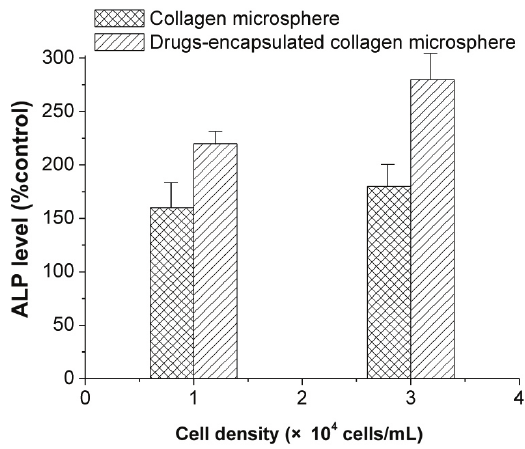
Figure 4. ALP expression level on pure collagen microspheres and drugs-encapsulated collagen microspheres after 7 days of culturing. Data are represented after being normalized to the tissue culture plate. Data are presented as means ± standard deviations for n=5. Statistically significant differences (p<0.05) were observed between the 2 types of microspheres for each culturing